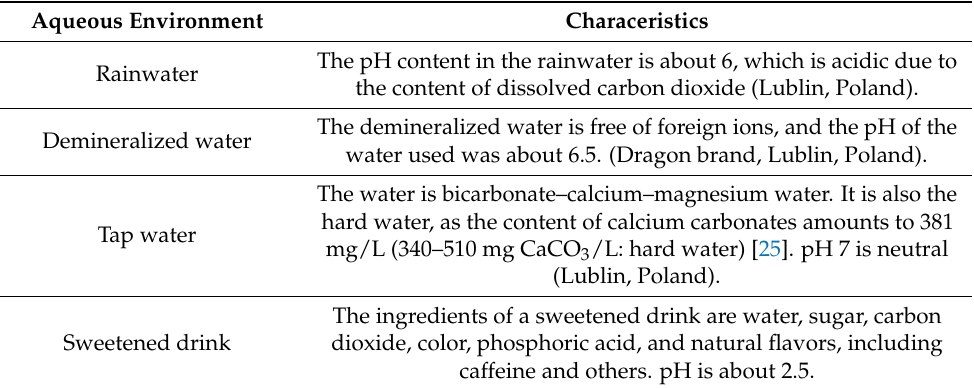
Table 3. Characteristics of the aqueous